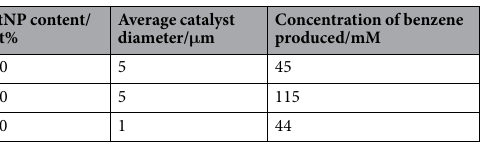
Table 3. Comparison of catalytic activity for PtNP@PDSP-5 catalysts with different PtNP contents and average particle sizes. The amount of PtNP@PDSP catalyst used for the test was 100